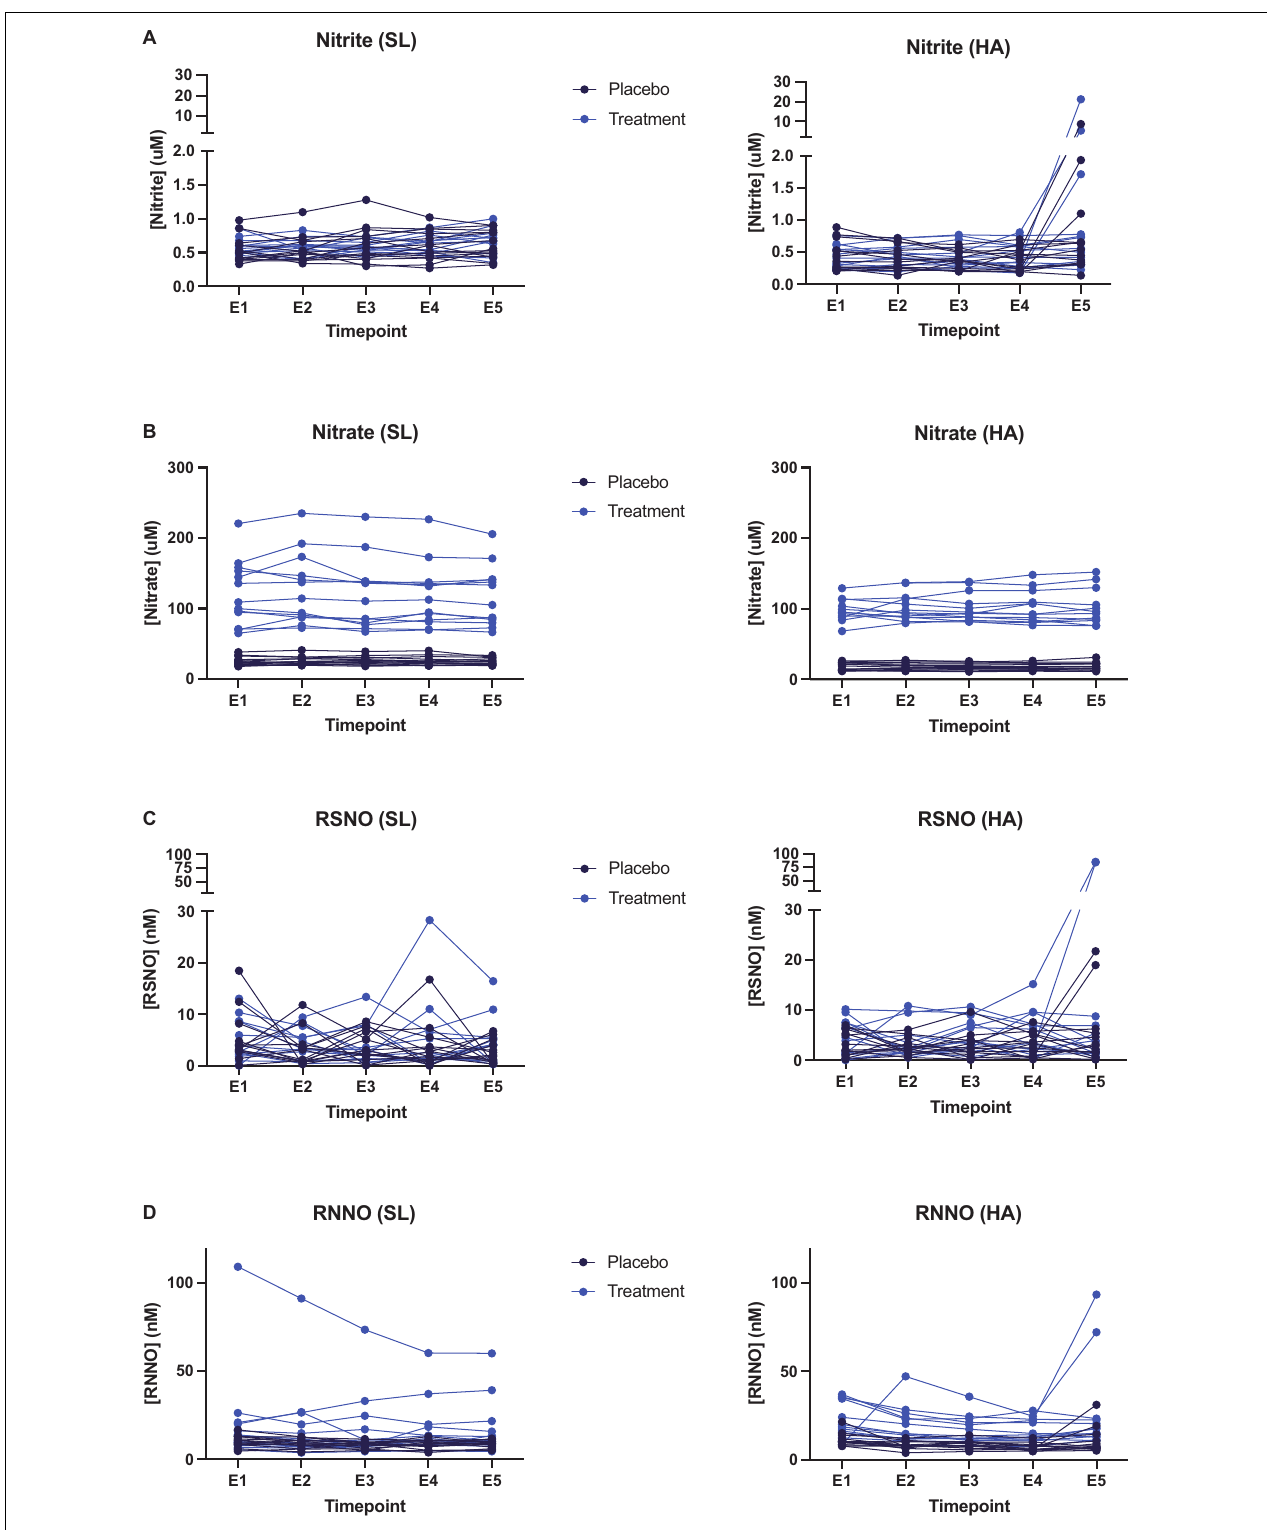
FIGURE 2 | Quantification of plasma biomarkers collected at different timepoints during exercise efficiency tests at both sea level (left hand panels) and high altitude (right hand panels) in participants taking either the placebo (black data points) or high nitrate (blue data points) supplement. (A) Plasma nitrite; (B) plasma nitrate; (C) plasma S-nitrosothiols (RSNO); (D) plasma N-nitrosamines (RNNO).